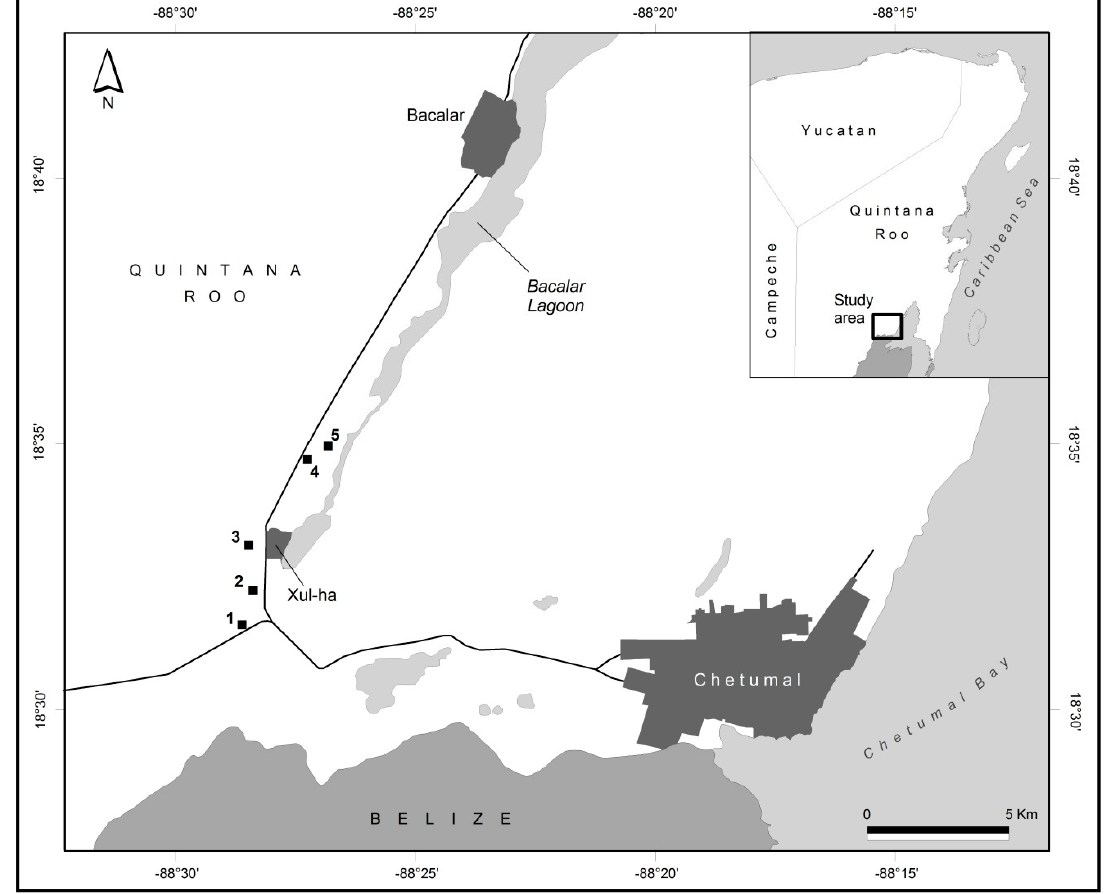
Figure 1. The location of the study area and of the sampled quarries.